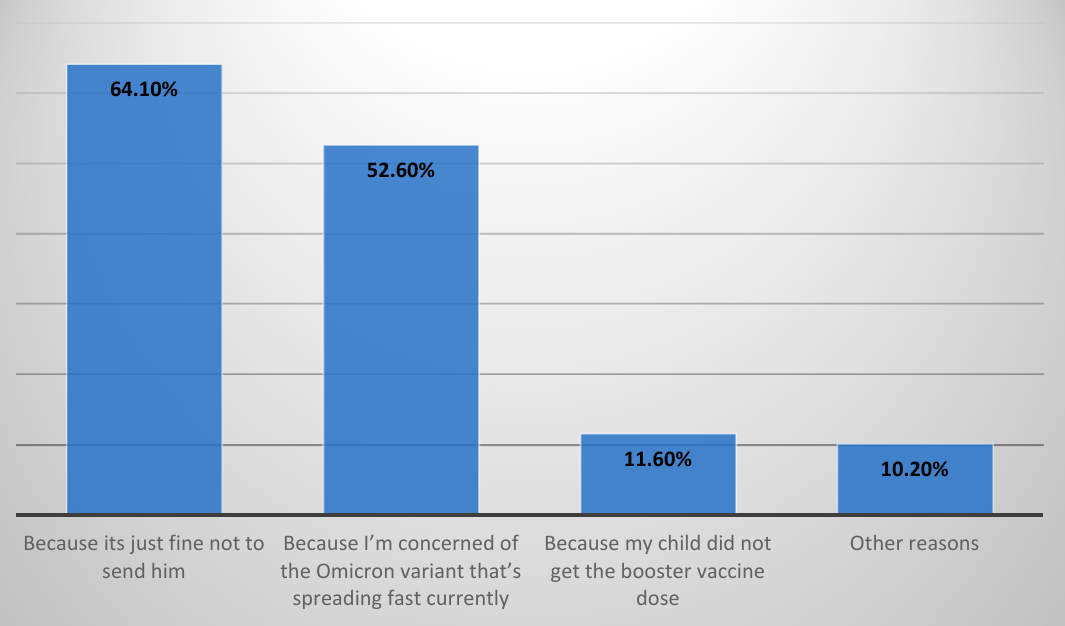
Figure A4. Parents’ reasoning of not sending their teenager child to school if COVID case reported in other classes.